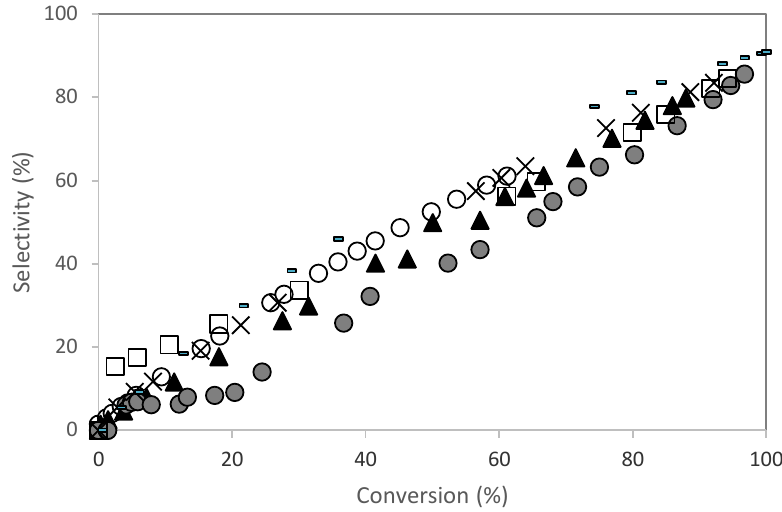
Figure 10. Hydration of camphene over PW4-SBA-15-SO 3 H catalyst. Effect of the catalyst amount.